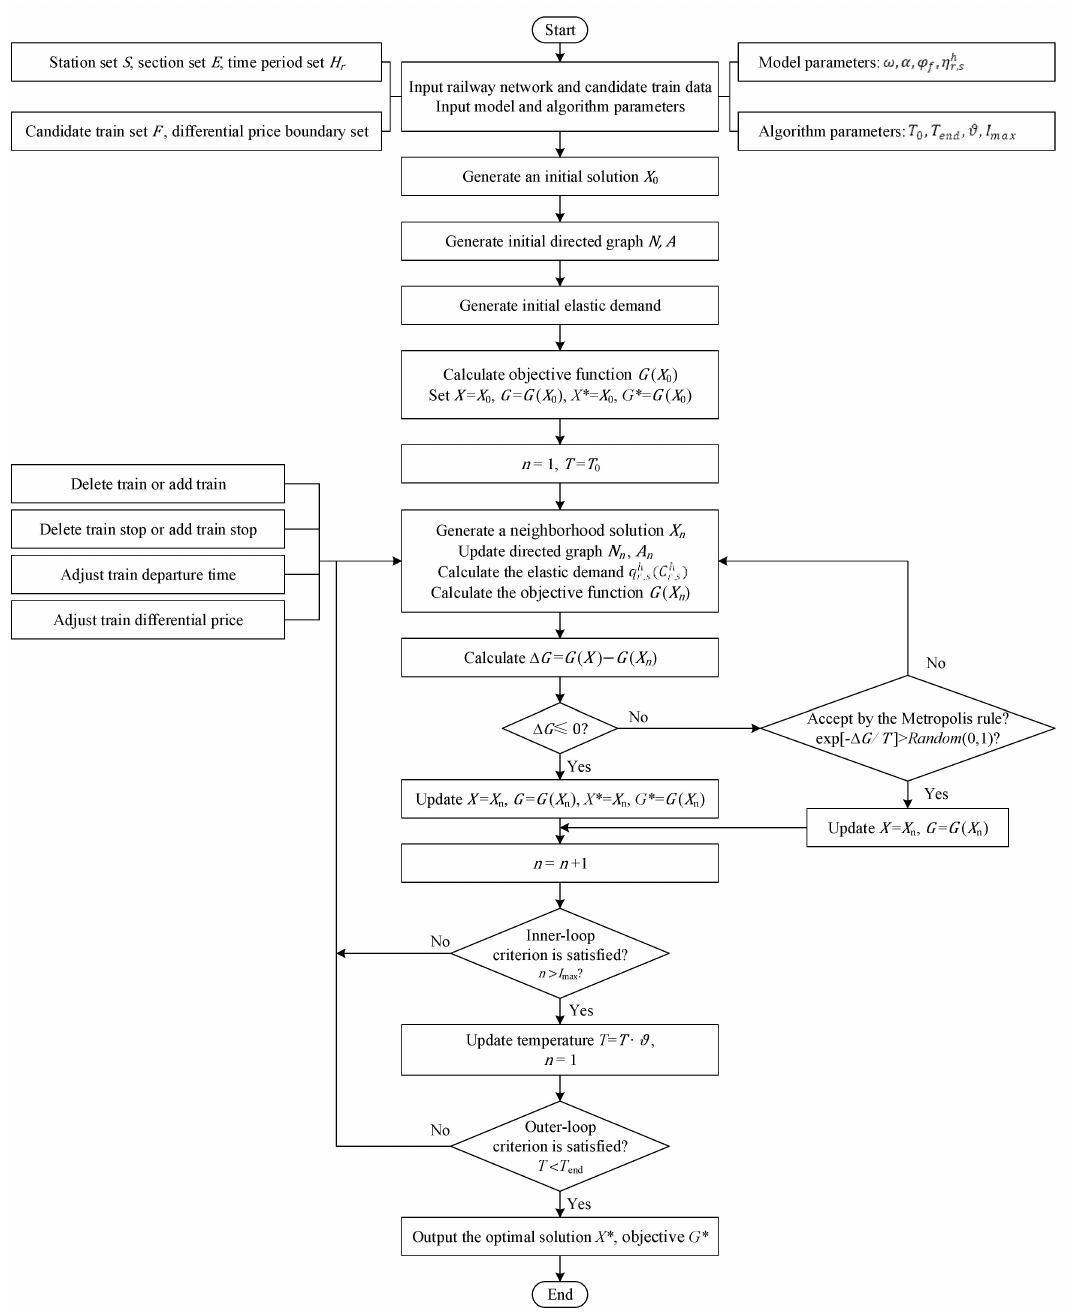
Figure 3. SAA-based solution algorithm